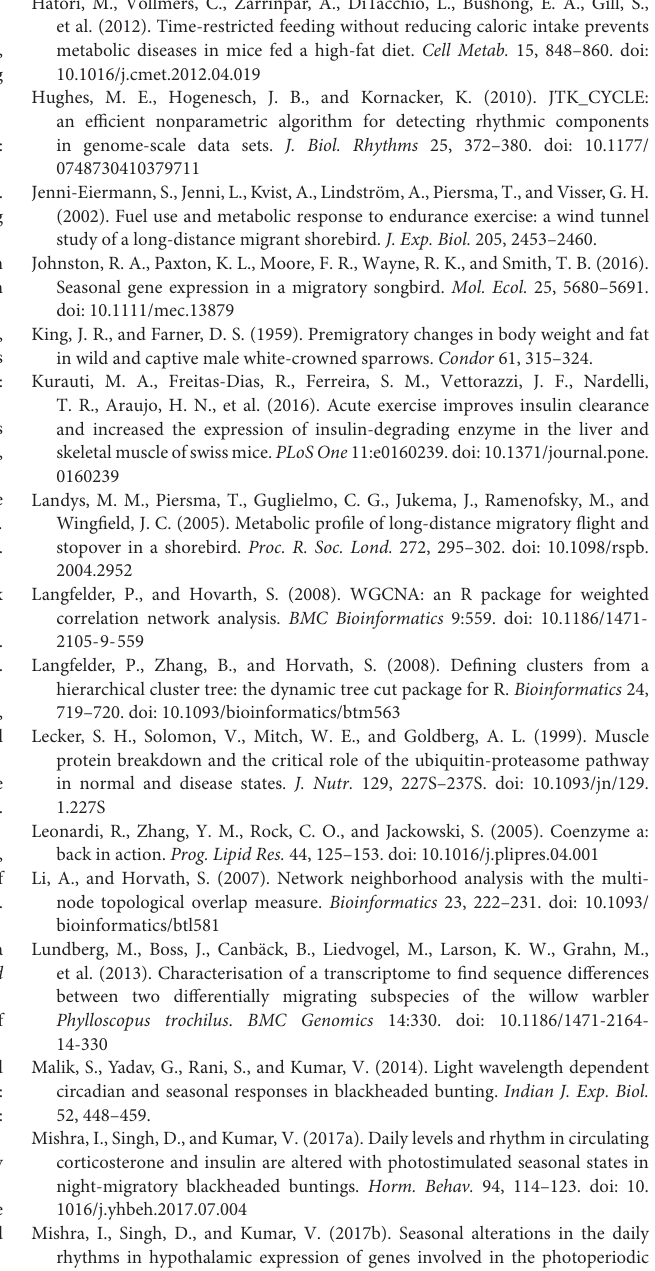
FIGURE S1 | Boxplot of log 2 FPKM expression values in 5–95% intervals of significantly coexpressed module specific hub genes (top panel, A ) blue and turquoise modules (bottom panel, B ). The outliers are shown as dot in each figure. Wilcox Rank sum test was used to test the significant difference between migratory (M) and non-migratory (nM) states. For significance, alpha was set at 0.05. TABLE S1 | Bunting liver sample transcriptome assembly and annotation statistics. TABLE S2 | List of differentially expressed genes under M and nM states. A gene was categorized as differentially expressed with threshold of false-discovery rate (FDR) of < 0.1 and absolute log 2 fold change > 0.1. Based on the expression